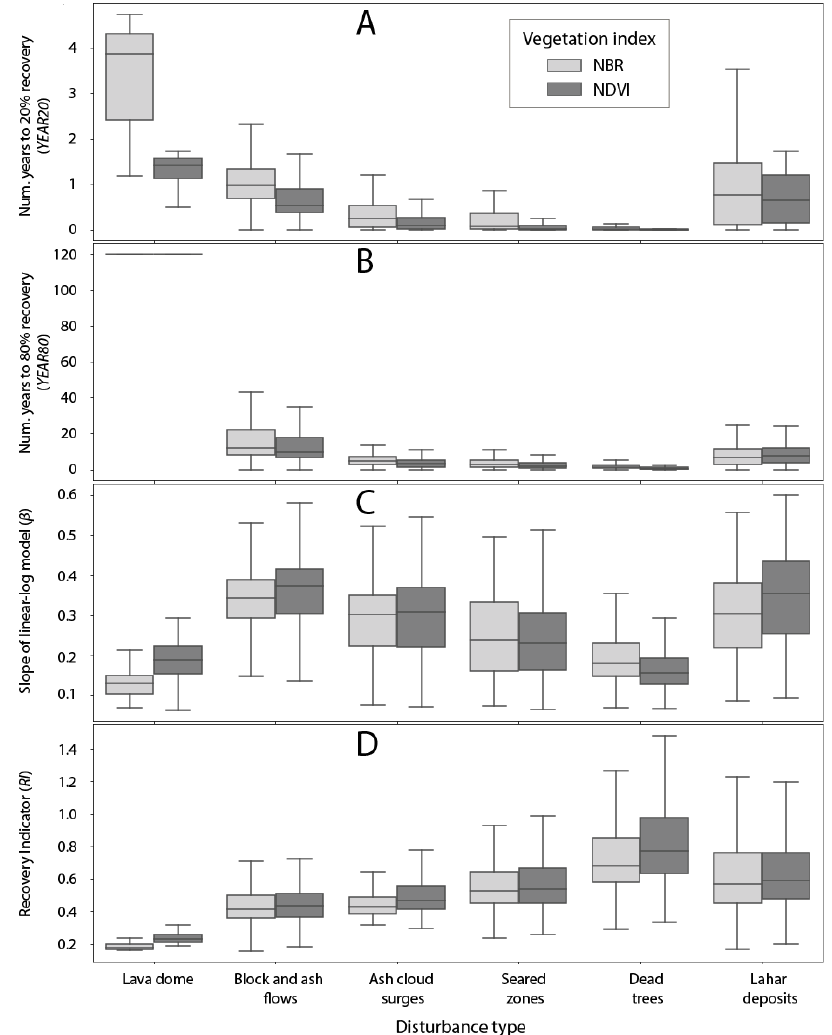
Figure 4. Distribution of recovery metrics ( y -axis) for each disturbance type ( x -axis) and for each vegetation index (legend). ( A ): Number of years required to reach 20% of the pre-eruption vegetation index value ( YEAR20 ); ( B ): Number of years to reach 80% of the pre-eruption vegetation index value ( YEAR80 ); ( C ): Slope ( β ) of the linear-log model; ( D ): Recovery indicator value ( RI) Table 3. Glass’s delta results, where results that indicate a large effect size ( ∆ ≥ 0.80) are in bold. Block and Ash Ash Cloud Seared Lava Dome Lahar Deposits Dead Trees Flows Surges